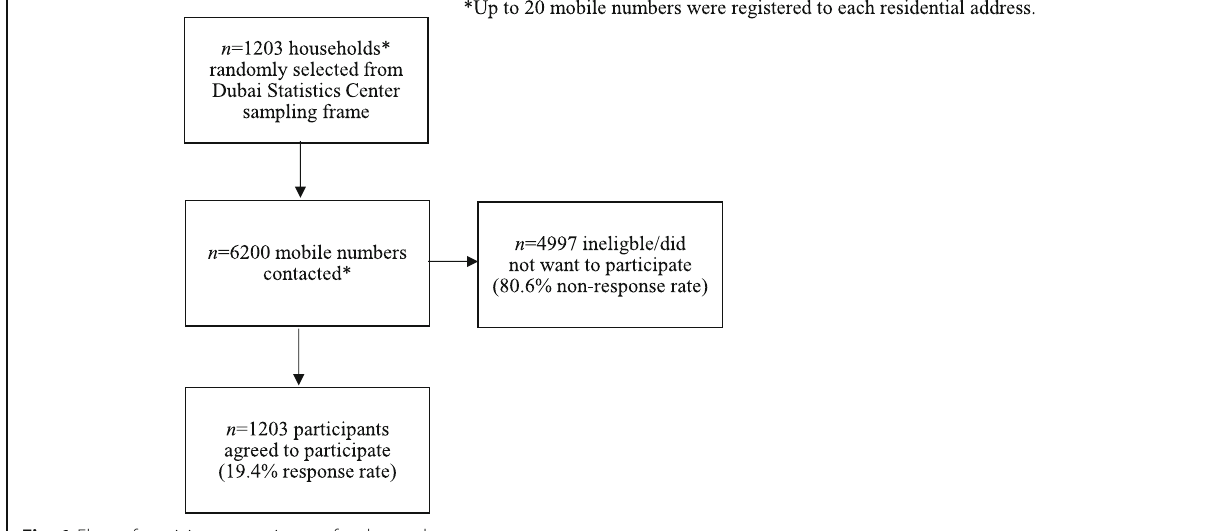
Fig. 1 Flow of participant recruitment for the